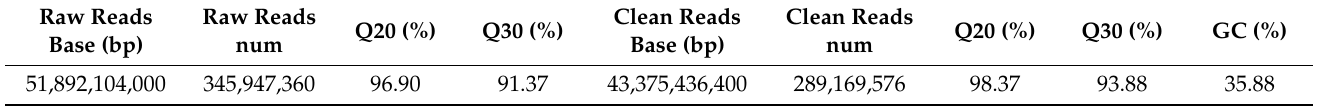
Table 2. Reads statistics for G. orientalis